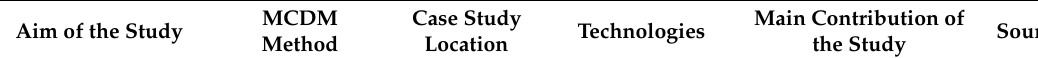
Table 2. Technology comparison